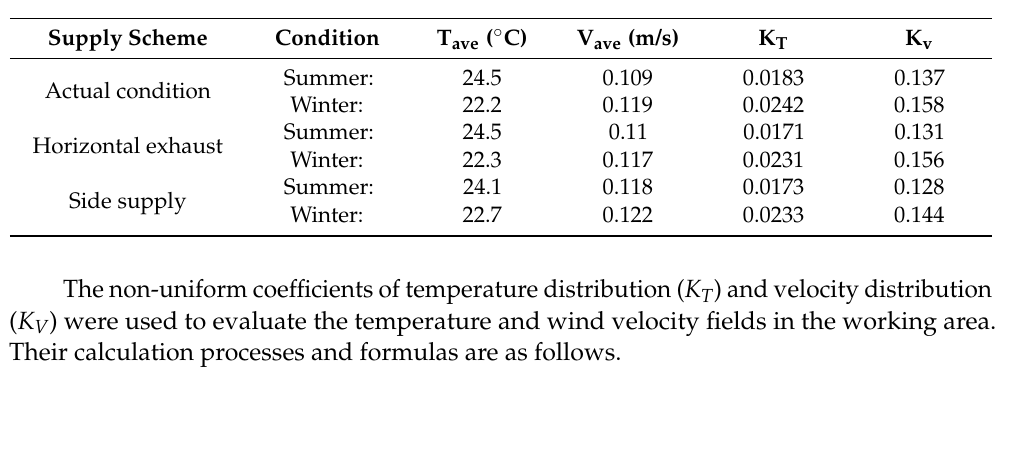
Table 3. Results comparison among the three air supply